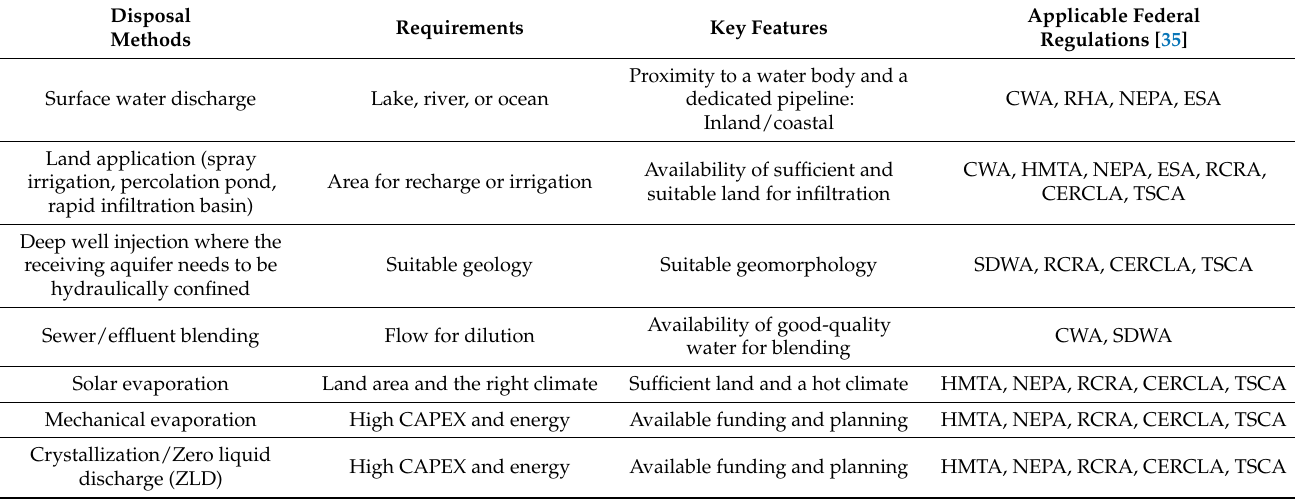
Table 1. The most common ROC disposal methods and regulations for